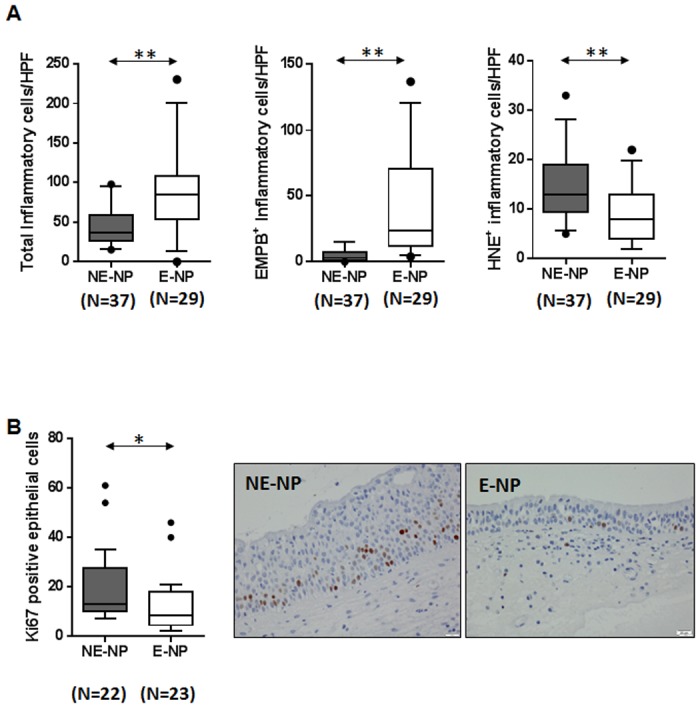

(A) Comparison of total inflammatory cells, EMBP+ cells, and HNE+ cell were performed in NP tissues between non-eosinophilic and eosinophilic CRSwNP patients (B) Expression of Ki–67 in NP tissues from non-eosinophilic and eosinophilic CRSwNP patients. Number of Ki-67-positive epithelial cells per 100 cells, averaged from three different areas of epithelium (*p<0.05, **p<0.01, and ***p<0.001). Data represent means (SD). E-NP, eosinophilic nasal polyp; NE-NP, non-eosinophilic nasal polyp.